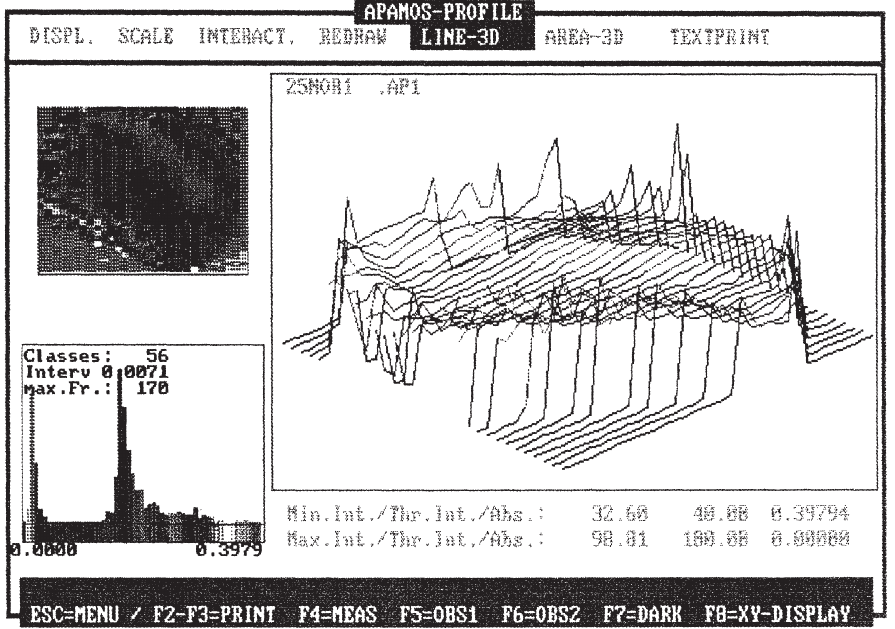
Fig. 5. Printout of the APAMOS program from an X - Y scan of a cylinder section. Homogeneity of the stain in the central area of the section can be evaluated employing the optical density profile and a colour-code diagram. A narrow area in the periphery of the section exhibits higher values due to the flare